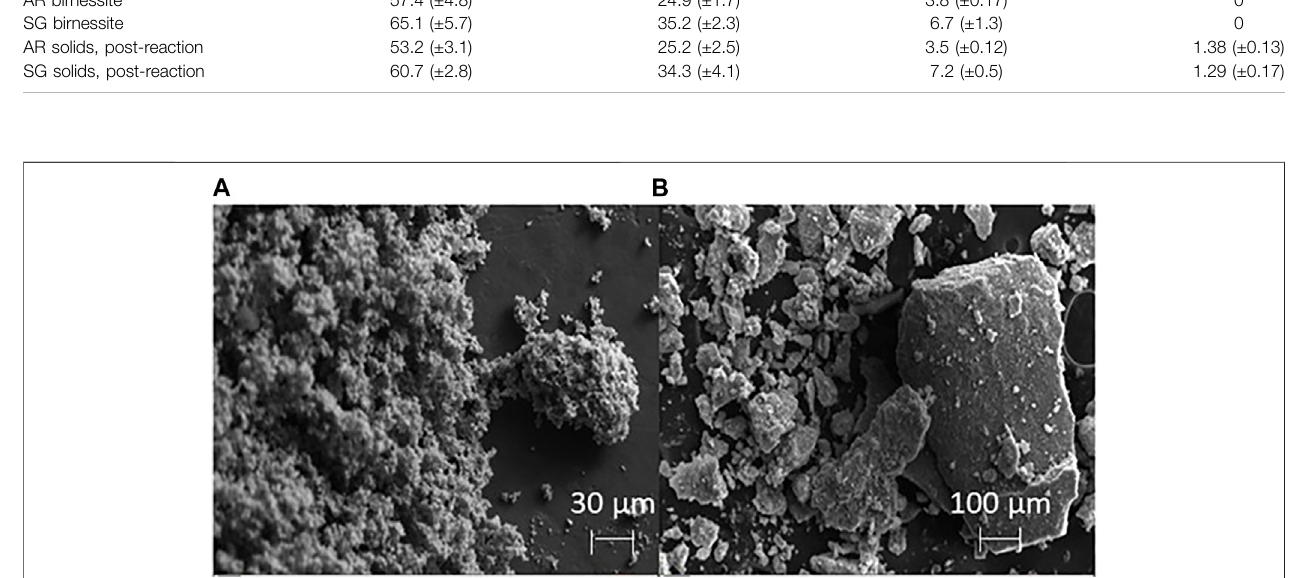
FIGURE 2 | SEM images of the synthesized birnessite using the AR method (A, scale bar is 30 μ m), and the SG method (B, scale bar is 100 μ m).